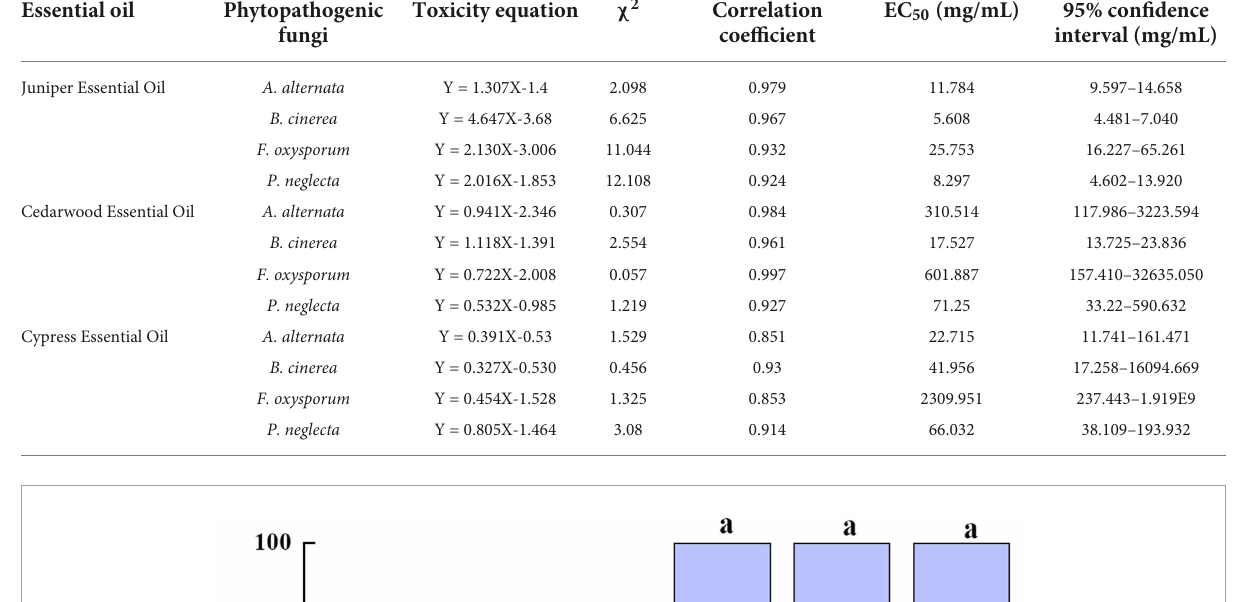
TABLE 1 Toxicity equations for juniper essential oil, cedarwood essential oil, and cypress essential oil against Alternaria alternata , Botrytis cinerea , Fusarium oxysporum, and Pestalotiopsis neglecta.